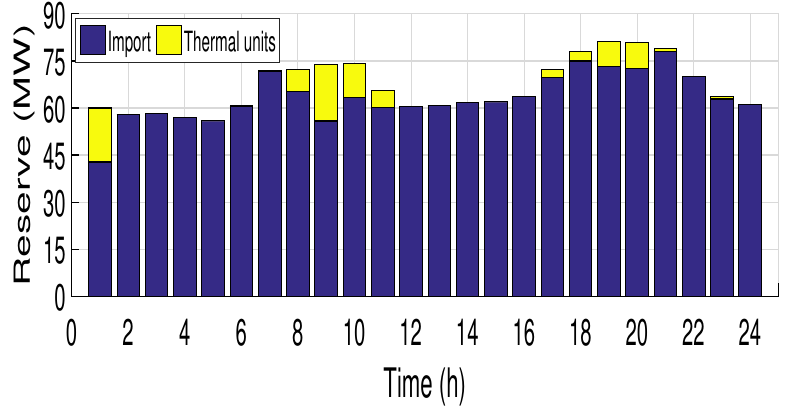
Figure 13. Scheduled reserve power in case 1.